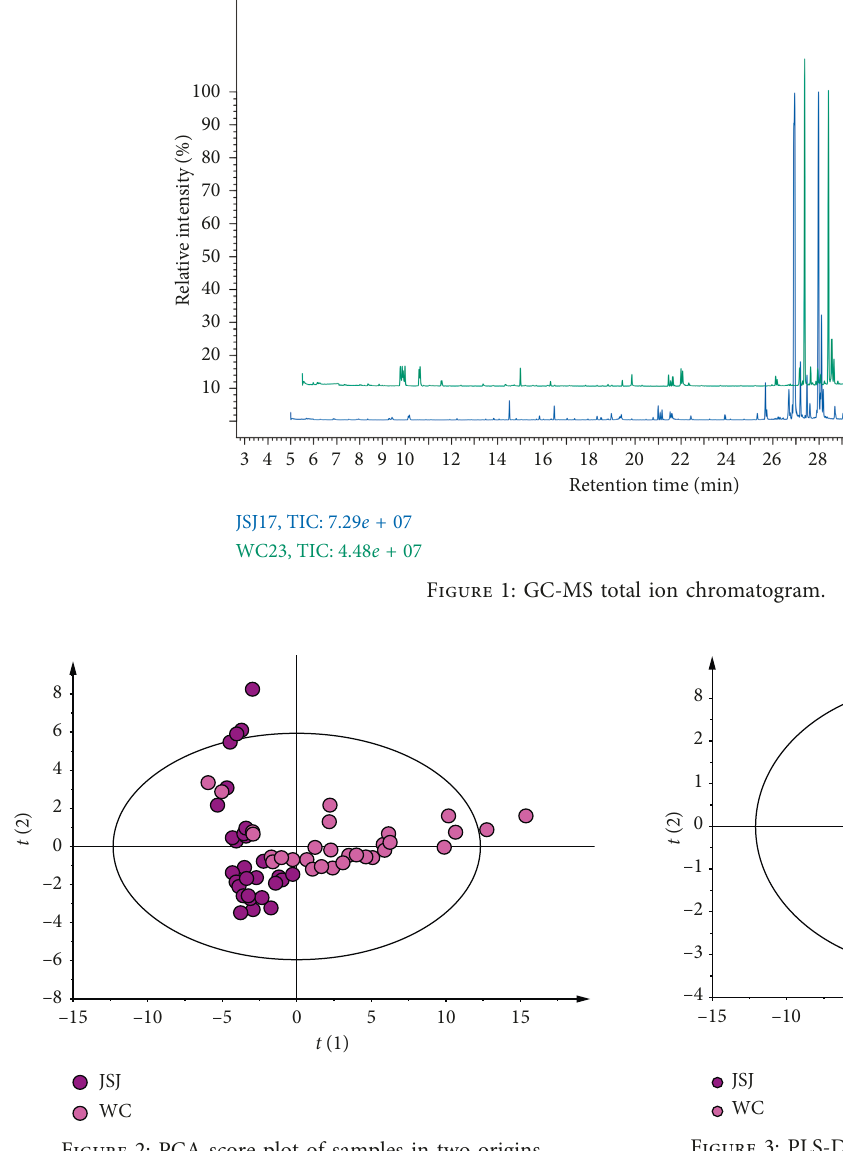
Figure 2: PCA score plot of samples in two